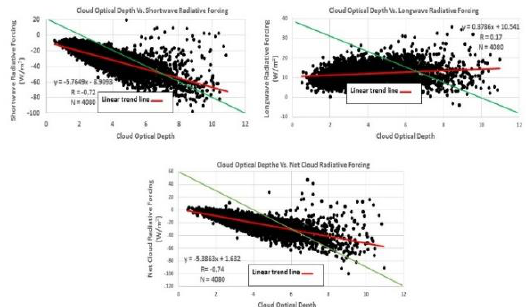
Figure 10. Scatter plots between monthly mean total cloud optical depth (unit less) with SWCRF, LWCRF, NCRF (Wm -2 ) from the CERES over the east box during June to September months of 2000–2008 Fig.10 suggests that SWCRF is negatively associated with the COD over the East box. The correlation between SWCRF and COD is -0.72. LWCRF is not showing any notable association with COD as evident from the scatter plot and the flat linear fit line. The correlation between COD and LWCRF is 0.17. As the SWCRF is exhibiting association with COD, NCRF is also associated with COD. The correlation between COD and NCRF is -0.74 which is statistically significant at 99% confidence level.